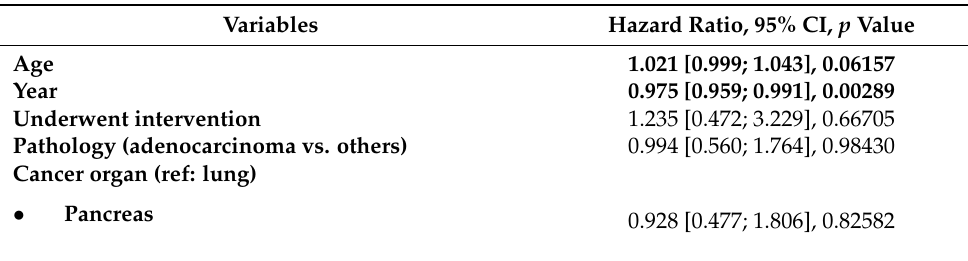
Figure 1. Trend of premortem diagnosis of marantic cases over the included study years among ( A ) the entire group ( p < 0.001), ( B ) lung cancer group ( p = 0.006), ( C ) pancreatic cancer group ( p = 0.014), ( D ) other GIT cancers ( p = 0.002), ( E ) gynecologic cancer (0.035), and ( F ) other cancers ( p < 0.001). Table 3. Predictors of late mortality using Cox regression